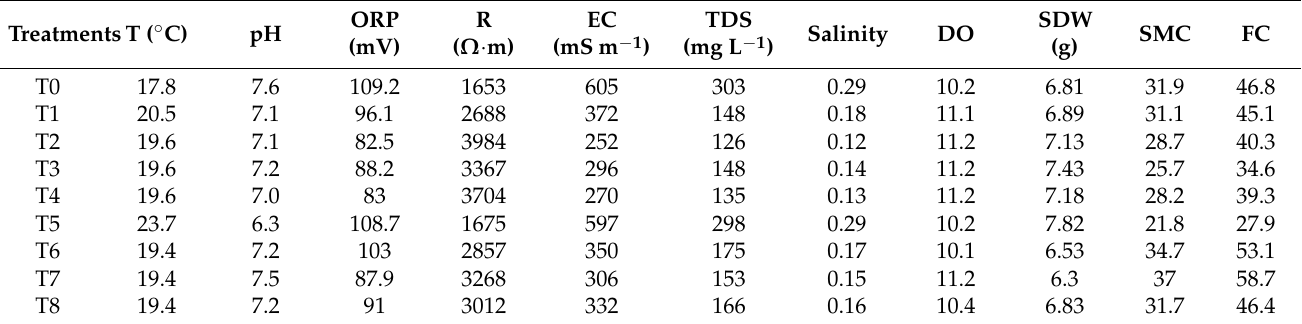
Table 1. Impact of drought stress on soil physicochemical parameters after experiment.